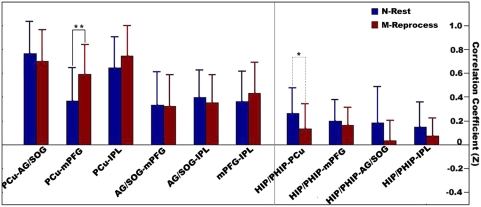
The functional connectivity (FC) between the STPs-network regions.The FC between the PCu and the mPFG was significantly stronger (** P<0.05, bonferroni corrected) during the M-Reprocess than during the N-Rest. However, the FC between the HIP/PHIP and the PCu showed a tendency to be weaker (* P<0.05, uncorrected) during the M-Reprocess than during the N-Rest.